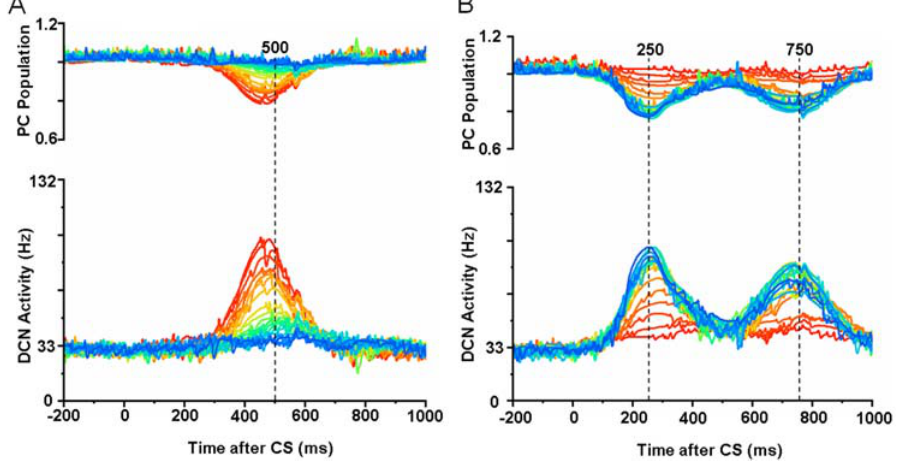
Figure 9. Extinction and double response. A. The progress of simulated extinction in DCN activity and the weighted sum of PC population activity are shown. Every 25 th trial is shown for clarity (red to blue is early to late). At the end of the training with ISI 500 ms (the first trace here, in red, is the same as the red curve in Figure 8) the CS signal was presented alone, without a US signal, causing extinction. B. Response to double-puff unconditioned stimuli. Progress of training with two alternating ISIs (US at 250 ms or at 750 ms) after one CS is shown. Every 30 th trial of 600 trials is shown (red to blue is early to late).